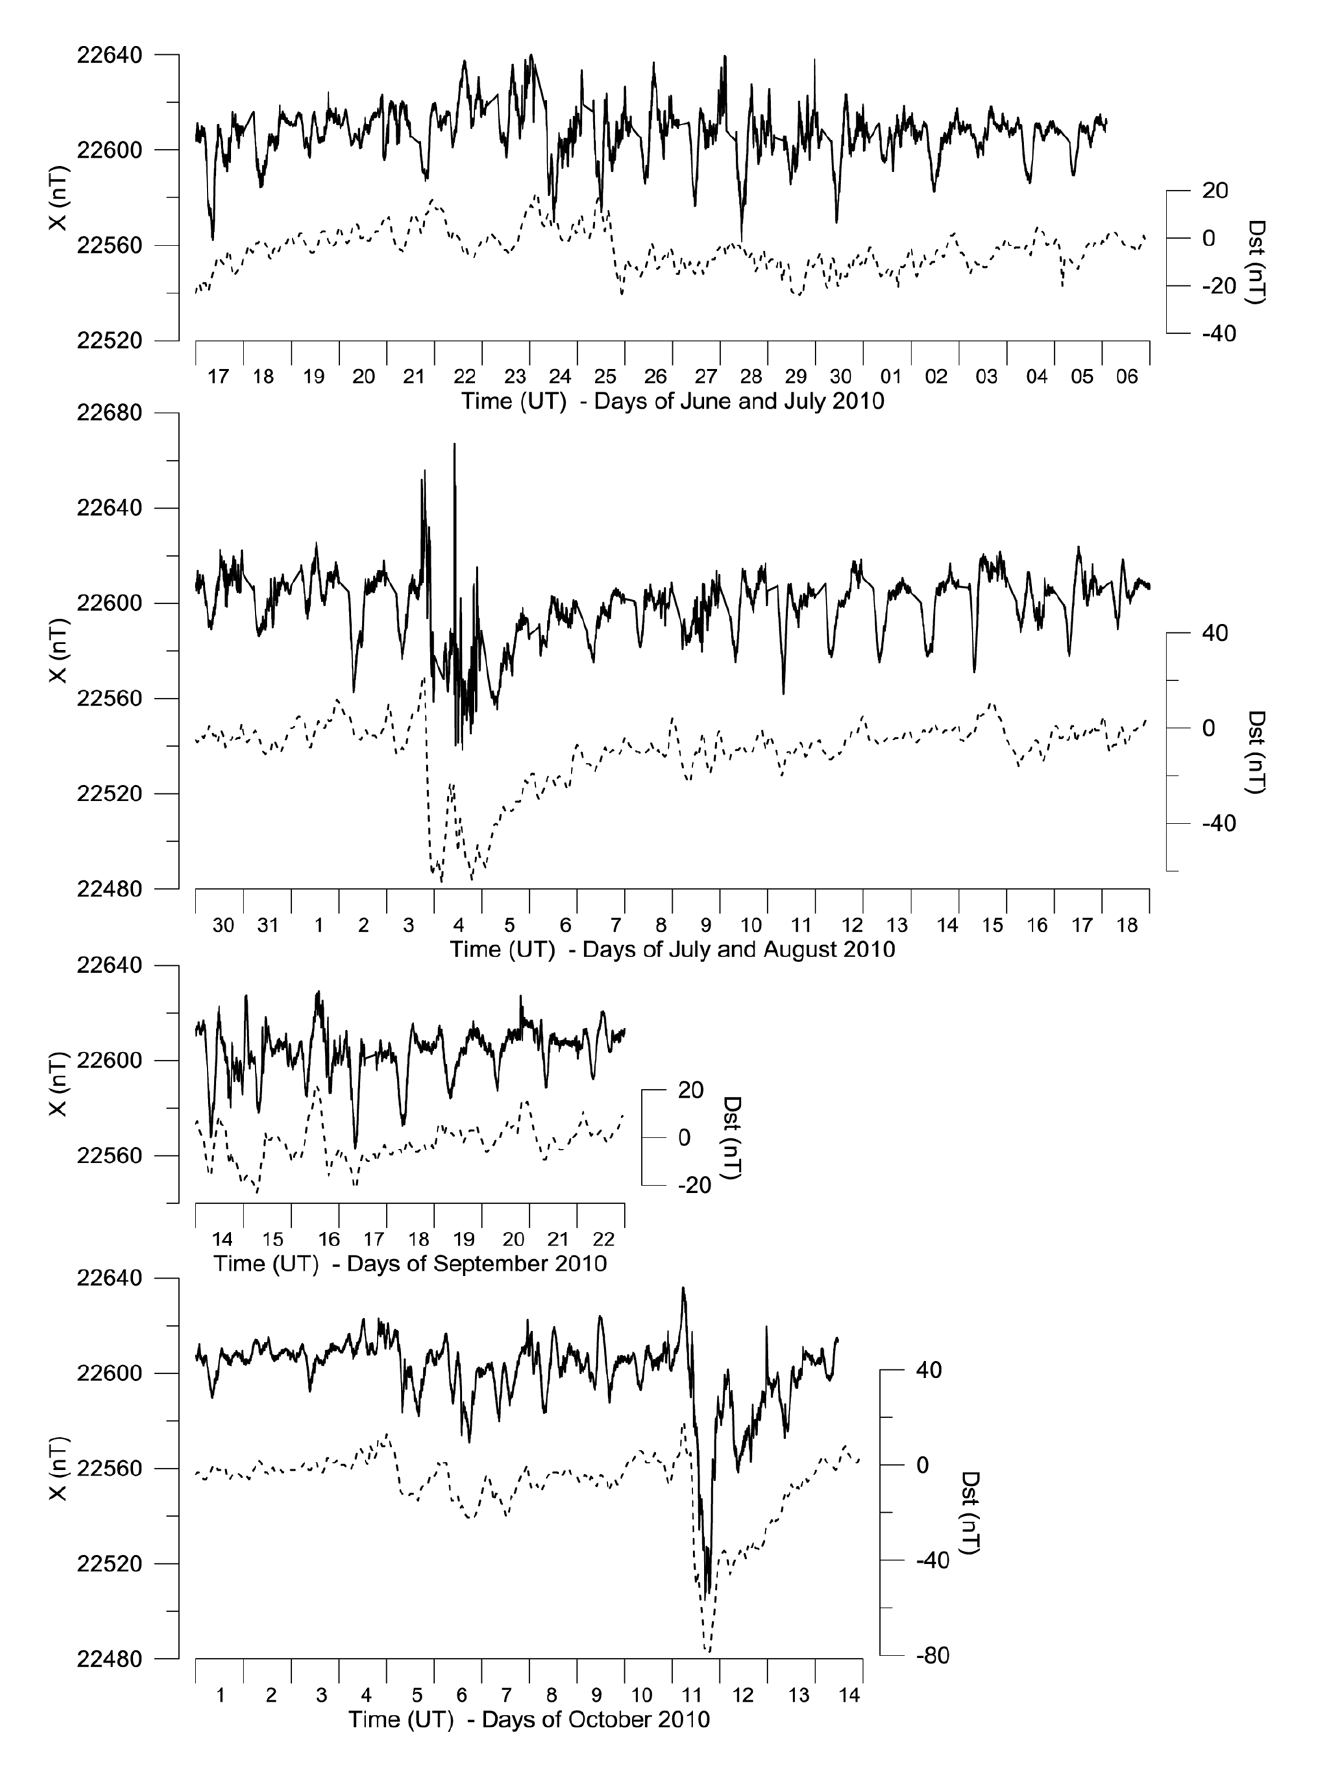
Figure 3. The horizontal northward component evolution recorded at SUA during the field campaigns. The Dst index plotted along illustrates the evolution of the geomagnetic